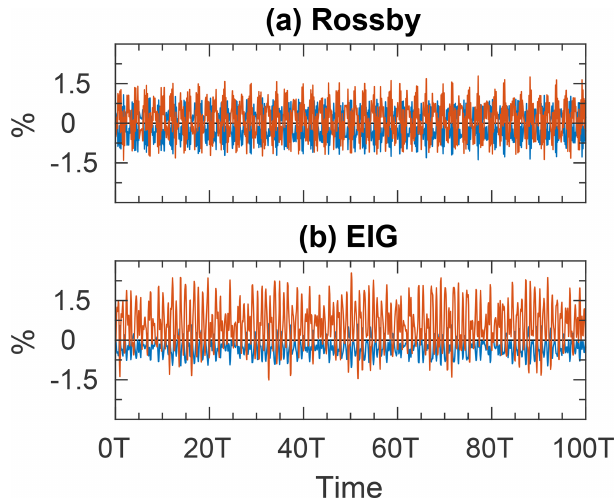
Figure 3. The structure error defined in Eq. (8) for both the Rossby (a) and EIG (b) waves as a function of time. Blue: cal- culated for the velocity vector u = (u,v) . Red: calculated for the geopotential (cid:56)